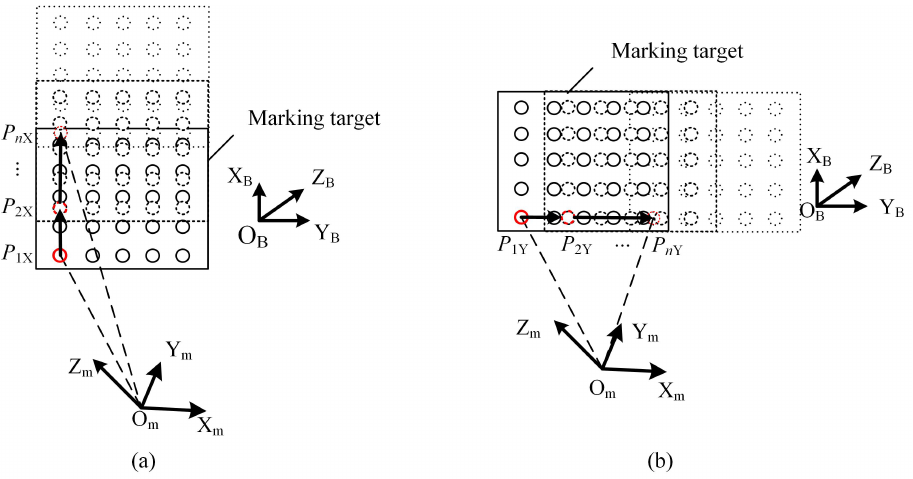
Figure 7. The measurement process of R BM . ( a ) Measure the direction vector of X-axis. ( b ) Measure the direction vector of